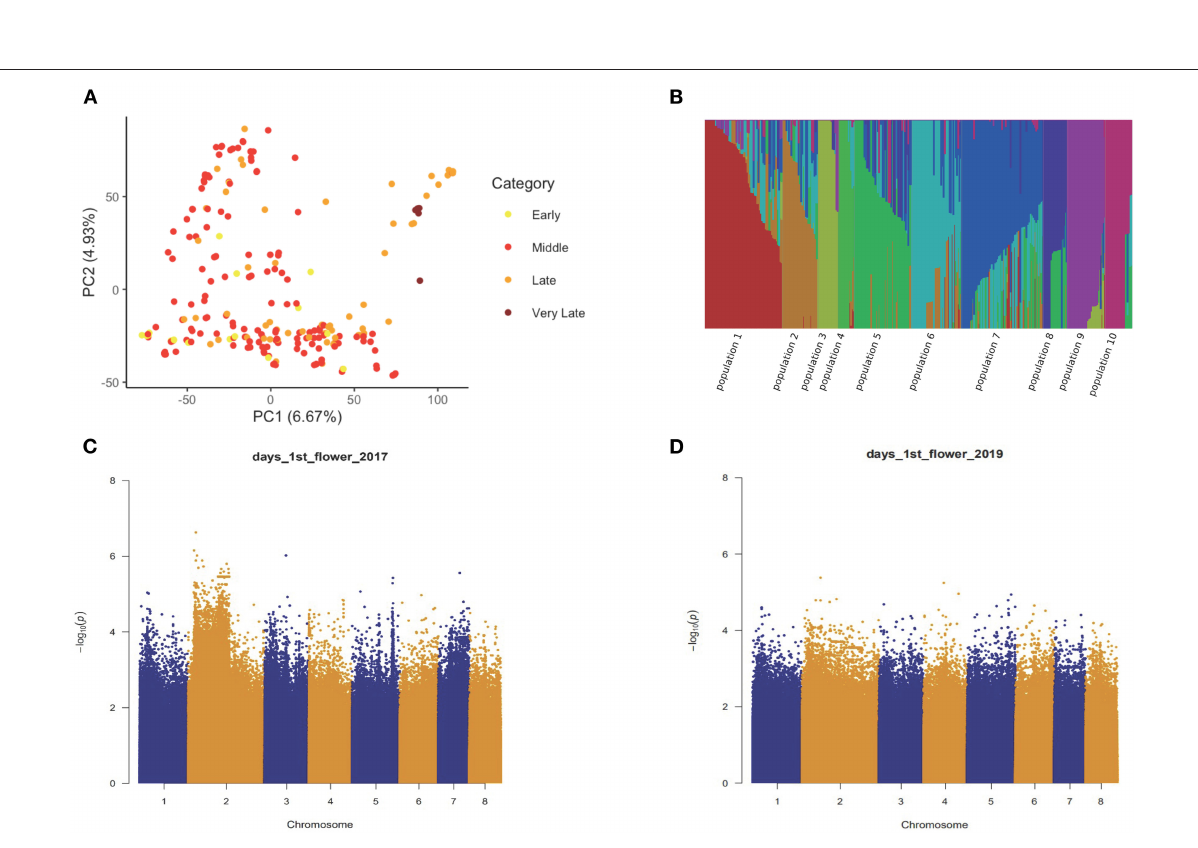
FIGURE 2 | The population structure analysis and single nucleotide polymorphism- (SNP-) based association tests of flowering time-related traits. (A) principal component analysis (PCA) biplot of 235 Prunus mume accessions. (B) fastSTRUCTURE analysis of 235 P. mume accessions based on k = 10. (C,D) Manhattan plot of –log 10 (value of p ) for SNP-wise associations with timing of the first flower in 2017 (C) and 2019 (D) .